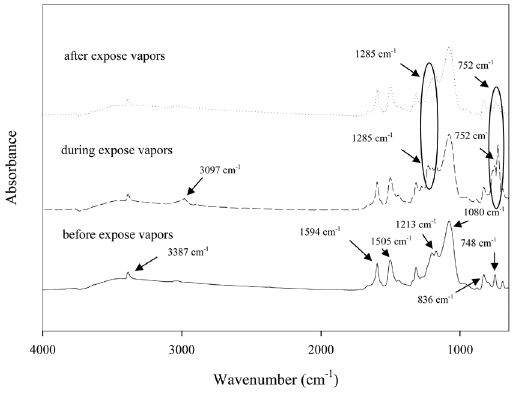
Figure 5. FT-IR spectra of D-PDPA/30% Y_H + [80] when exposed to DCM and DCE vapors at 27±1°C and 1